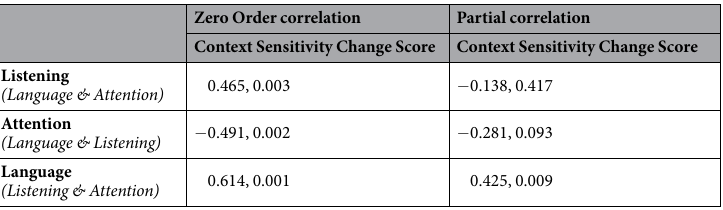
Table 3. Partial correlations between Context Sensitivity Change scores and each of Listening (SAP), Language (GCC) and Attention (Cognitive Problems/Inattention), while controlling for the remaining two variables (italicised